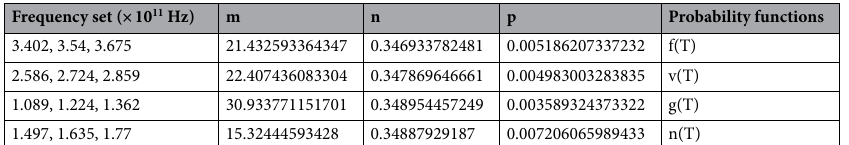
Table 1. Values for various probability functions are given, and they are identified by the notations as f(T), v(T), g(T) and n(T), which correspond to various sets of frequencies.